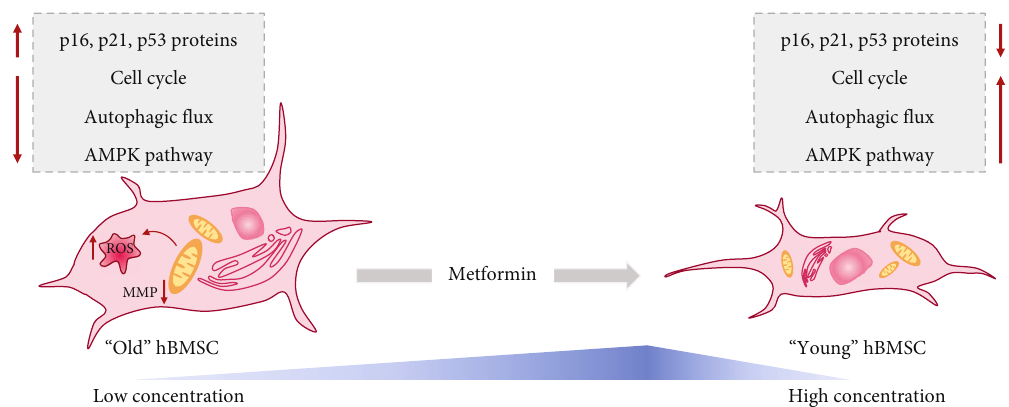
Figure 6: Schematic diagram of antiaging e ff ect of metformin in hBMSCs. Metformin exerts antiaging function within the low concentration range by enhancing autophagic fl ux. hBMSCs: human bone marrow-derived mesenchymal stem cells; ROS: reactive oxygen species; MMP: mitochondrial membrane potential; AMPK: 5 ′ AMP-activated protein